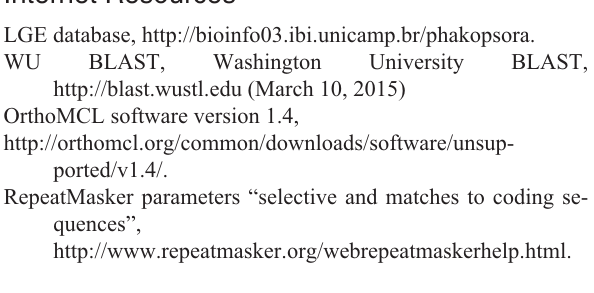
Table S1 - Sequences of RT-qPCR primers, amplicon size, and primer efficiency. Table S2 - The 50 top expressed P. pachyrhizi transcripts at 10 days post soybean